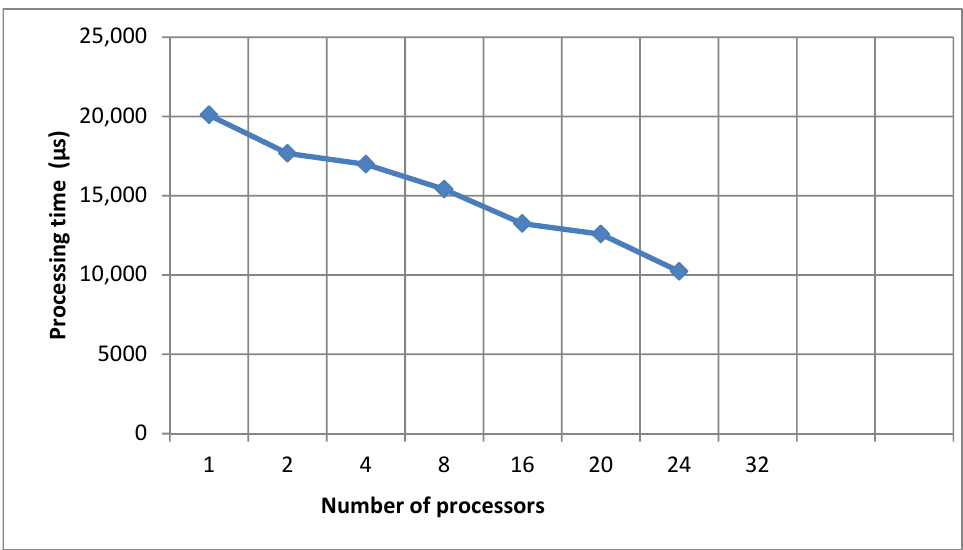
Figure 10. Dependence of SVD processing time on the number of computing processors at a matrix